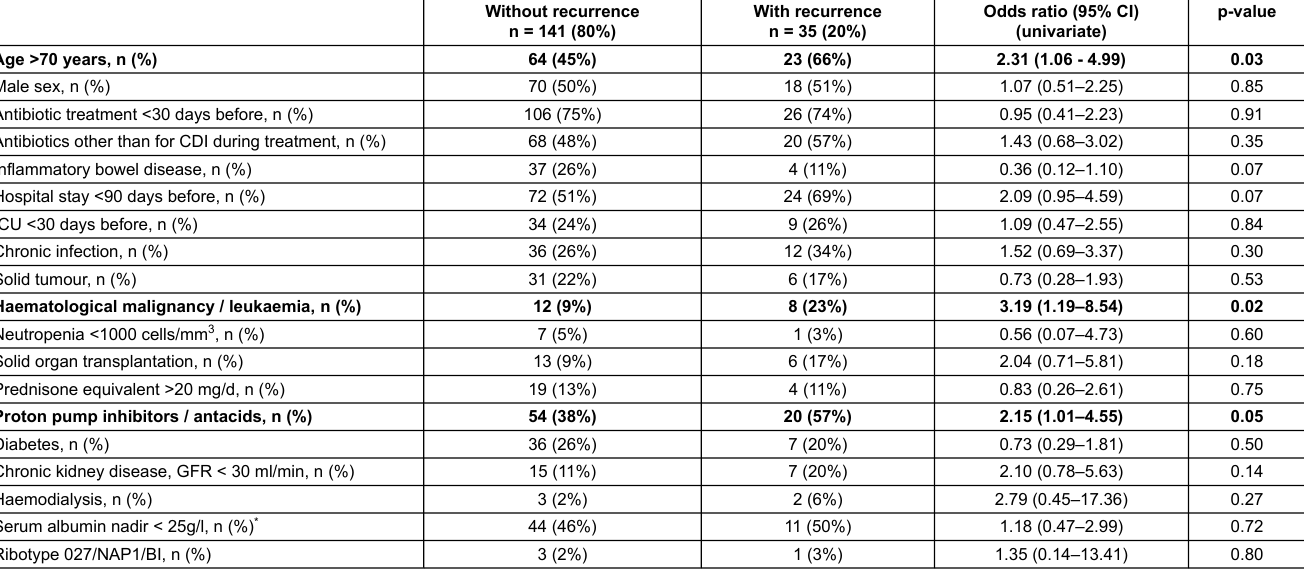
Table 2: Characteristics of patients with and without recurrent Clostridioides difficile infection (CDI). Odds ratios with 95% confidence intervals for recurrence of CDI by univari- ate logistic regression analysis.